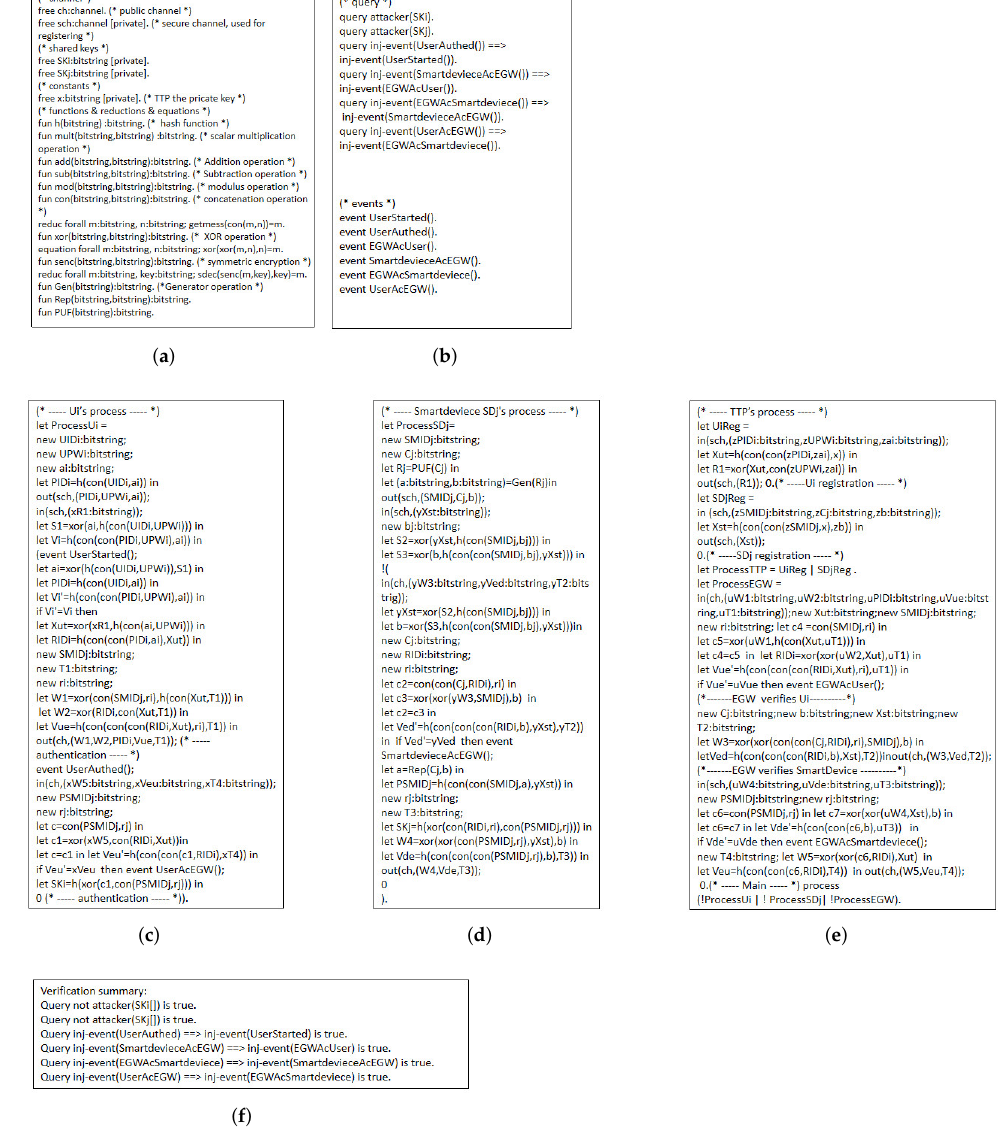
Figure 6. Simulation process in ProVerif. ( a ) Definitions; ( b ) the queries and events; ( c ) execution process of U i ; ( d ) execution process of SD j ; ( e ) execution process of TTP and EGW ; ( f ) verification